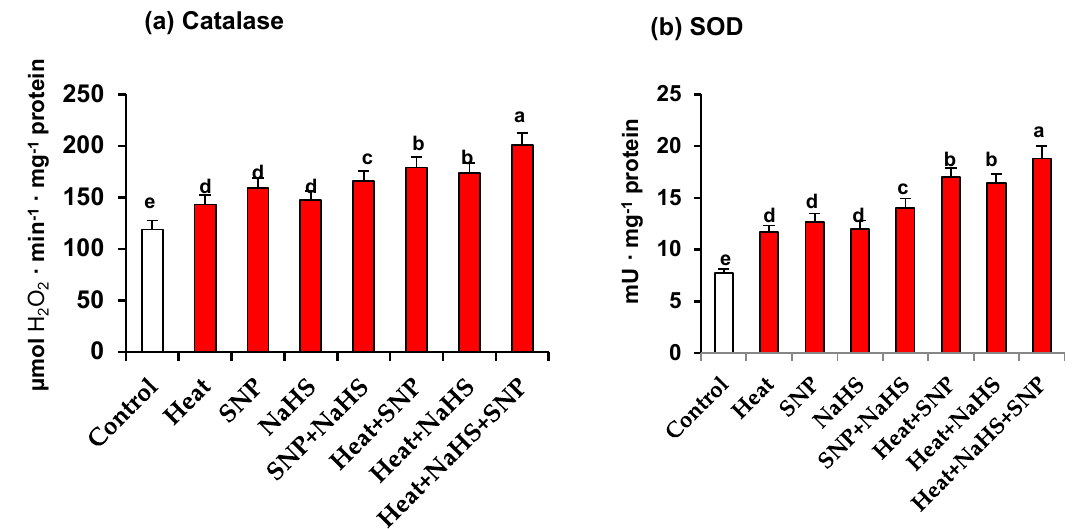
Figure 6. ( a ) Catalase activity and ( b ) superoxide dismutase (SOD) activity in wheat (Triticum aestivum L. var. WH 542) leaves treated with SNP (100 µM) and/or NaHS (200 µM) in the presence (40 °C) or absence (25 °C) of heat stress at 30 days after sowing (DAS). Data followed by the same letter are not significantly different by LSD test at ( p < 0.05). SNP, sodium nitroprusside; NaHS, sodium hydrosulfide.